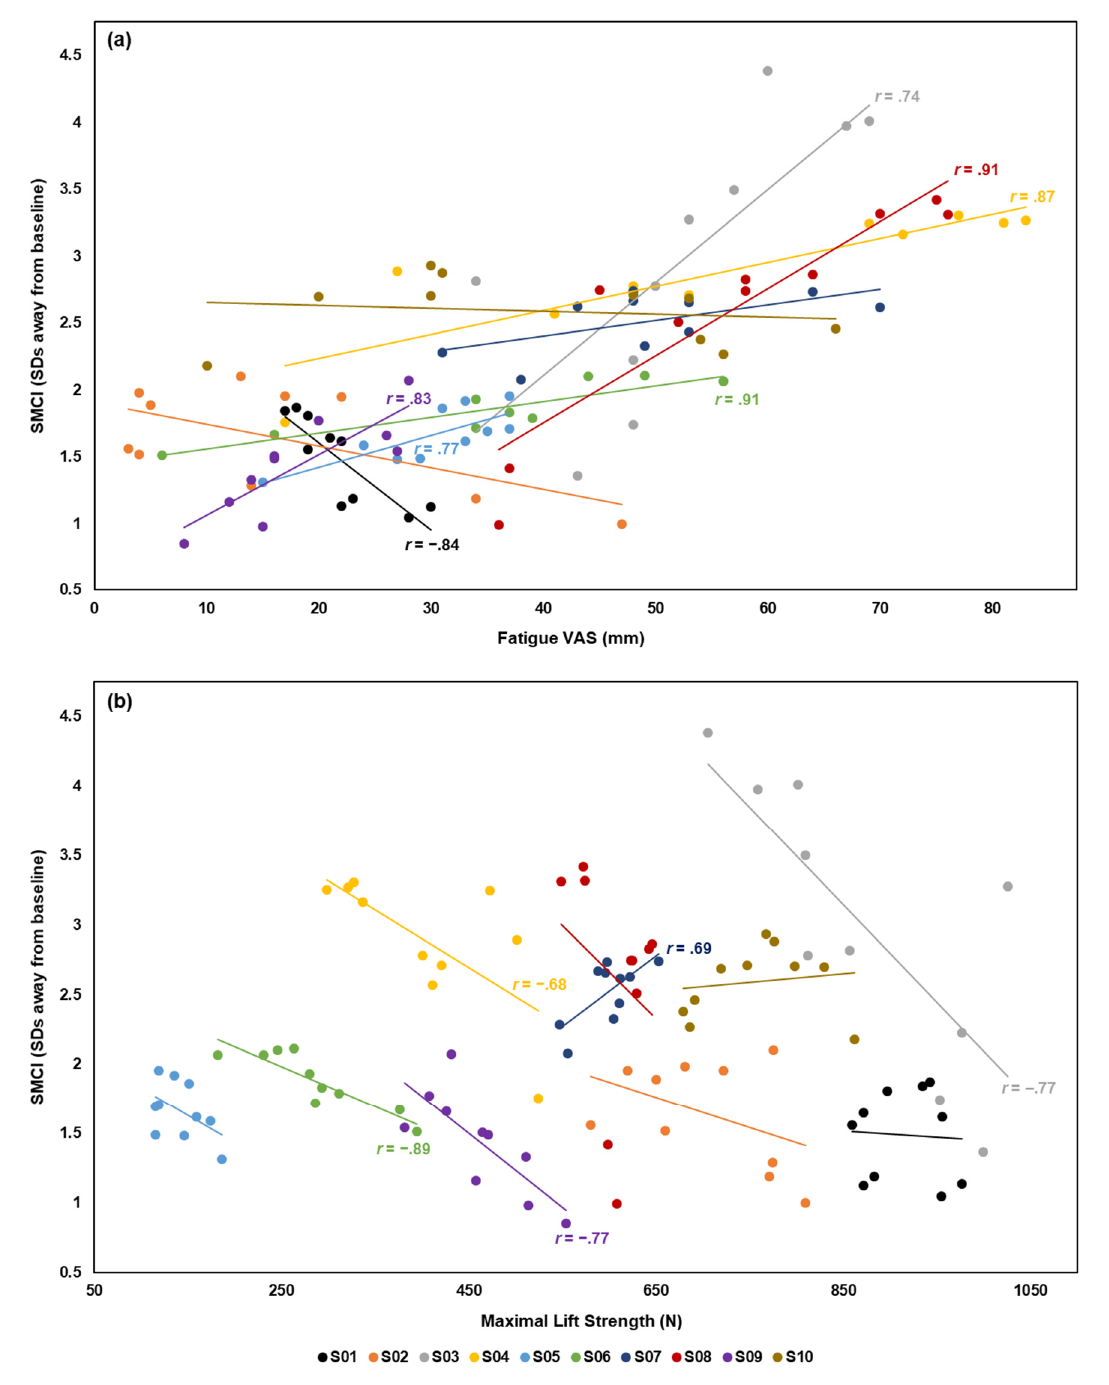
Figure 3. The subject-specific correlations between ( a ) the spine motion composite index (SMCI) and fatigue visual analogue scale (VAS) and between ( b ) the SMCI and maximal lift strength. Participants are identified as S01 to S10. Pearson’s correlation coefficients ( r ) are presented with the subject-specific trendlines for statistically significant correlations ( α = 0.05).